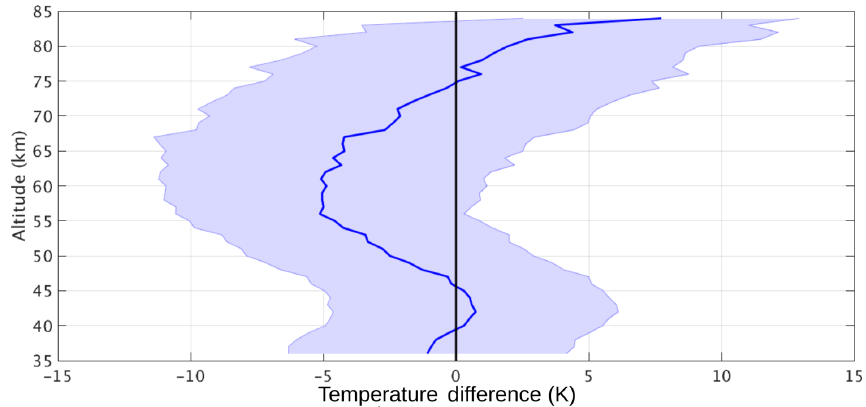
Figure 4. Statistical median temperature difference between OHP lidar and GOMOS temperature profiles (lidar minus GOMOS temperature). The shaded area represents the dispersion of the differences (1 standard deviation).